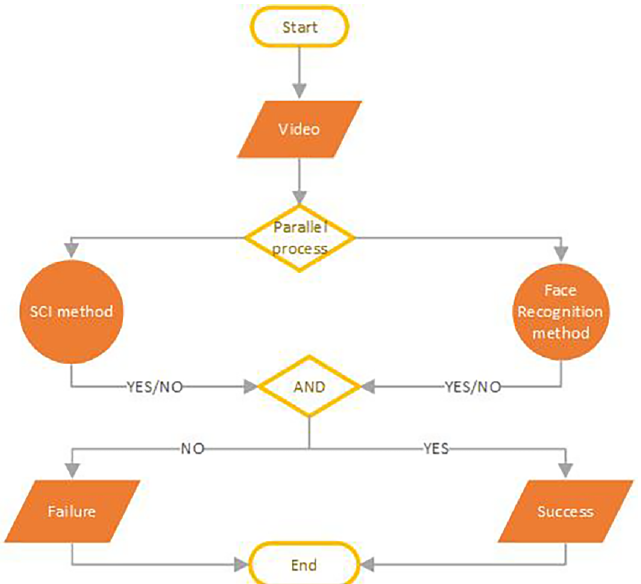
Figure 1. Flow-Chart of biometric face recognition system with Source Camera Identification (SCI). The facial recognition process and the SCI method work as long as both the procedures are successful. Otherwise, the general system